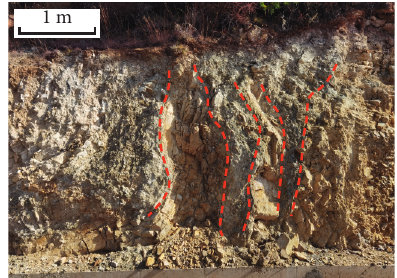
Figure 6: Outcrop of secondary weak structure B.